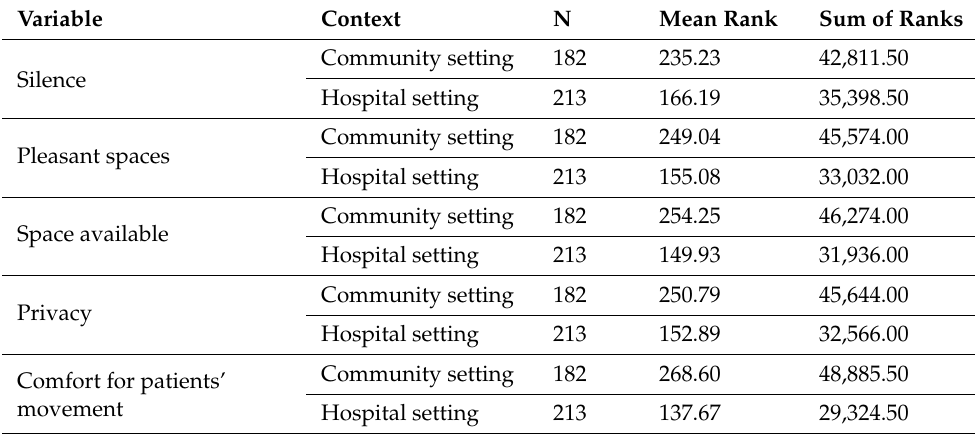
Table 3. Mean ranks for Mann–Whitney U test, following Table 2 results.